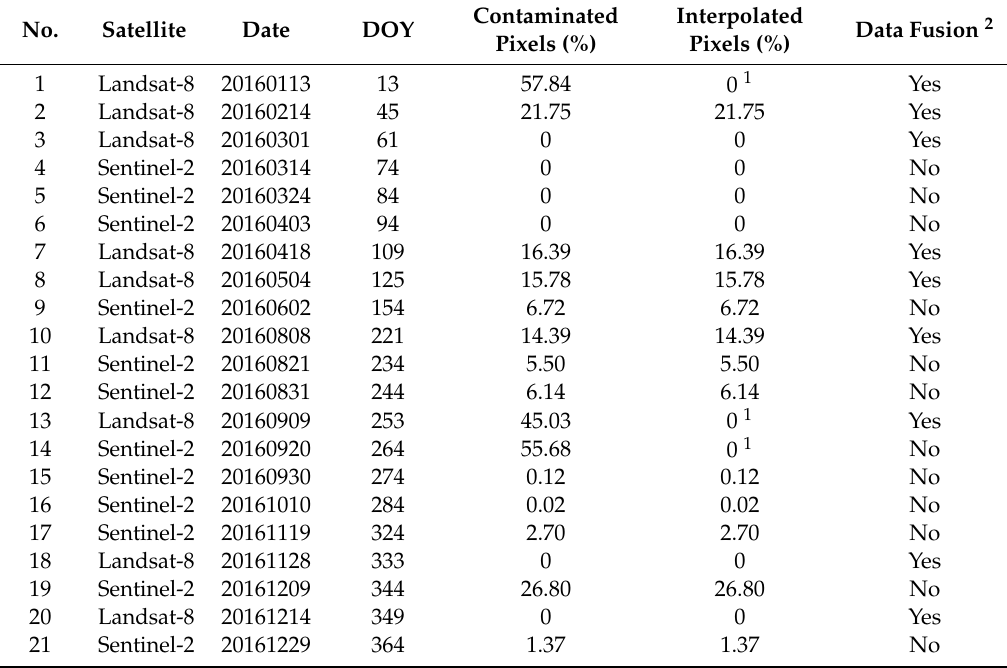
Table 2. Summary of Landsat-8 and Sentinel-2 images used in this